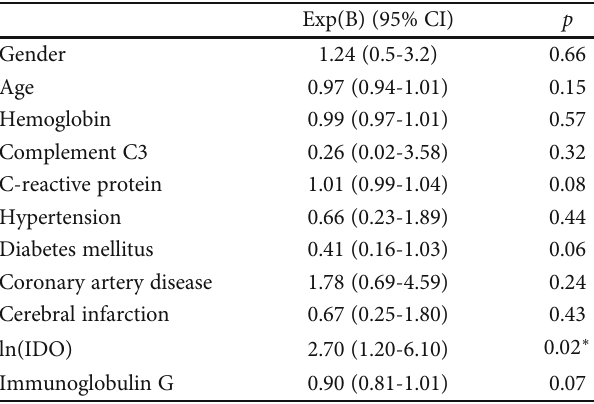
Table 5: Binary logistic analysis of independent risk factors of